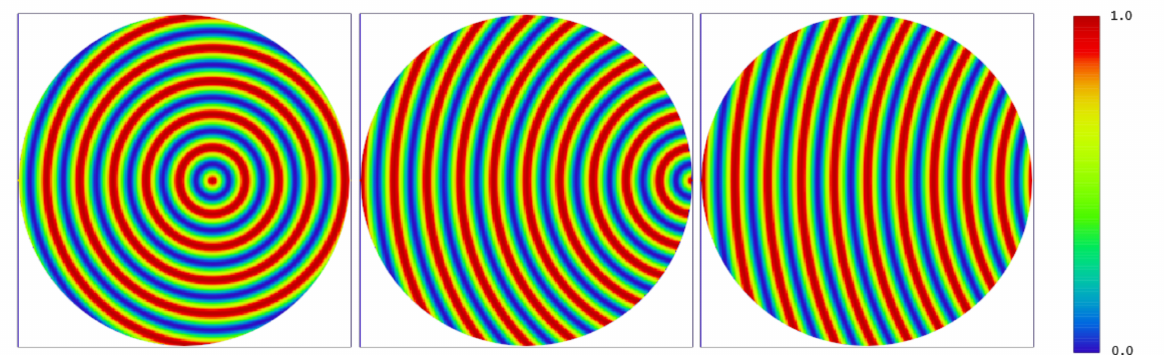
Figure 7. Off-axis TM representation, with increasing decenter position moving left to right; 10 cy/ap, normalized surface